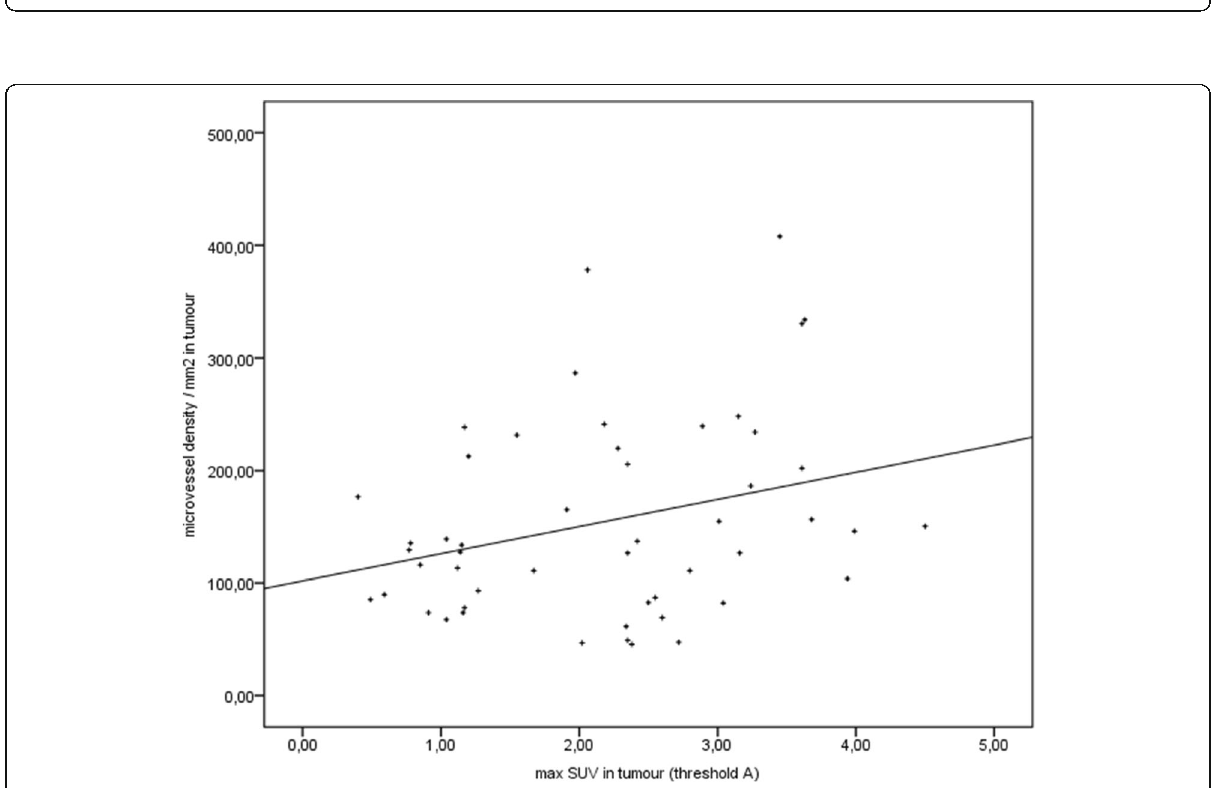
Fig. 9 Correlation. Spearman ’ s rank correlation between the maximal SUV in [18F]FDG-PET and the microvessel density (MVD, [MVD/mm 2 ]); r = 0.294, p =